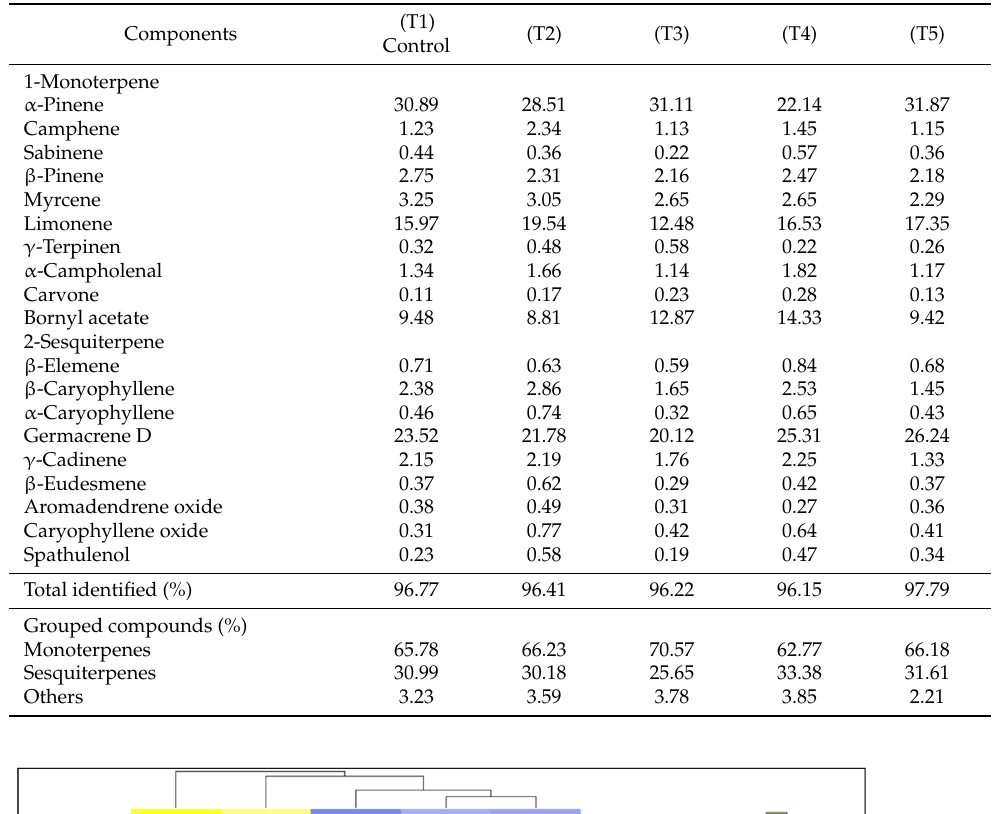
Table 8. Essential oil (EO) components in aerial parts under drought conditions and different nanoparticle applications on Solidago canadensis plants during the 2020 and 2021 growing seasons.